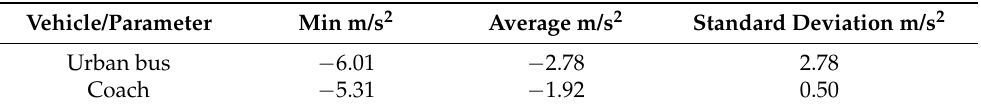
Table 6. Statistical characteristics of the acceleration values accumulated under the regular driving conditions of the analyzed vehicles during braking.